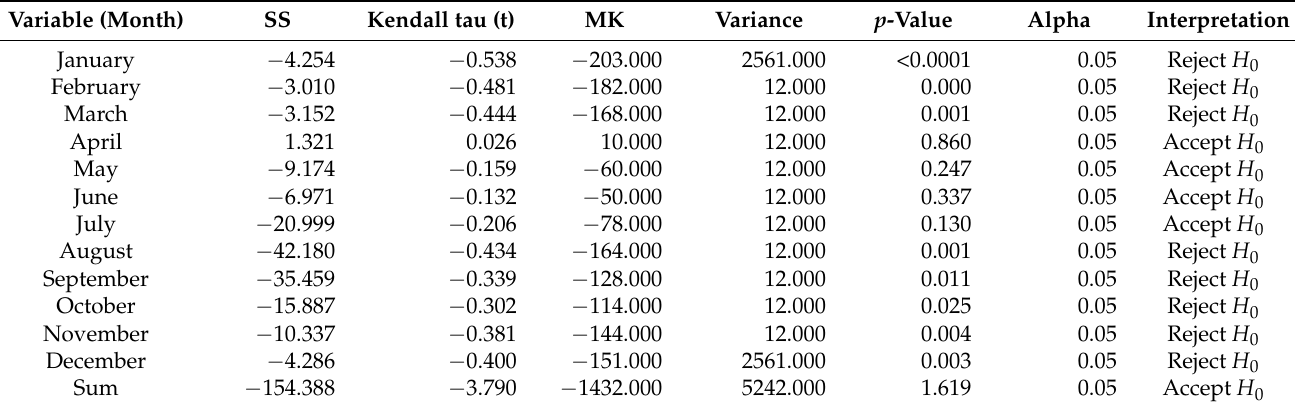
Table 10. SS and MK test results for the Novoselenginsk station.